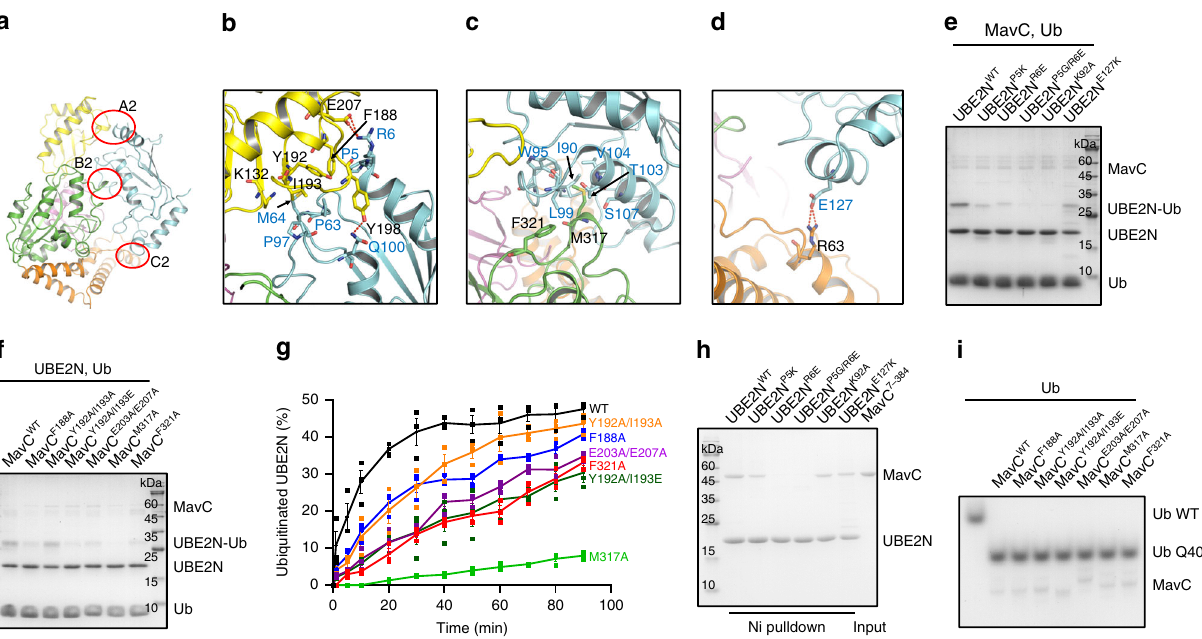
Fig. 2 The interaction between MavC and UBE2N. a Overview of the interface between MavC and UBE2N in the MavC/UBE2N/Ub complex. b – d Detailed interfaces of MavC – UBE2N interaction as marked in a , including A2 b , B2 c , and C2 d . Hydrogen bonds are represented as red dashed lines. e UBE2N and its mutants were incubated with MavC and Ub for 10 min at 37 °C. Then the samples were treated as in Fig. 1i. f Disrupting MavC – UBE2N interactions decreased the activity of MavC. MavC and the mutants were incubated with UBE2N and Ub for 10 min at 37 °C. Then the samples were treated as in Fig. 1i. g Kinetic analysis of MavC and the mutants targeting the UBE2N-binding surface. The percentage of ubiquitinated UBE2N was calculated by the amount of produced UBE2N – Ub divided by the sum of produced UBE2N – Ub and free UBE2N, at different reaction time points. Data shown are mean values± SEM ( n = 3 independent experiments). The representative gels used for the quanti fi cation are shown in Supplementary Fig. 8. h Ni pull-down experiment, combined with mutagenesis experiments to evaluate the roles of UBE2N residues in MavC – UBE2N interaction. i MavC mutants disrupting MavC – UBE2N interactions did not show dampened deamidase activity. MavC and its mutants were incubated with Ub for 2 h at 37 °C. Then the samples were subjected to native gel, followed by Coomassie blue staining. Source data are provided as a Source Data fi le. Experiments in e , f , h , and i were repeated independently three times with similar